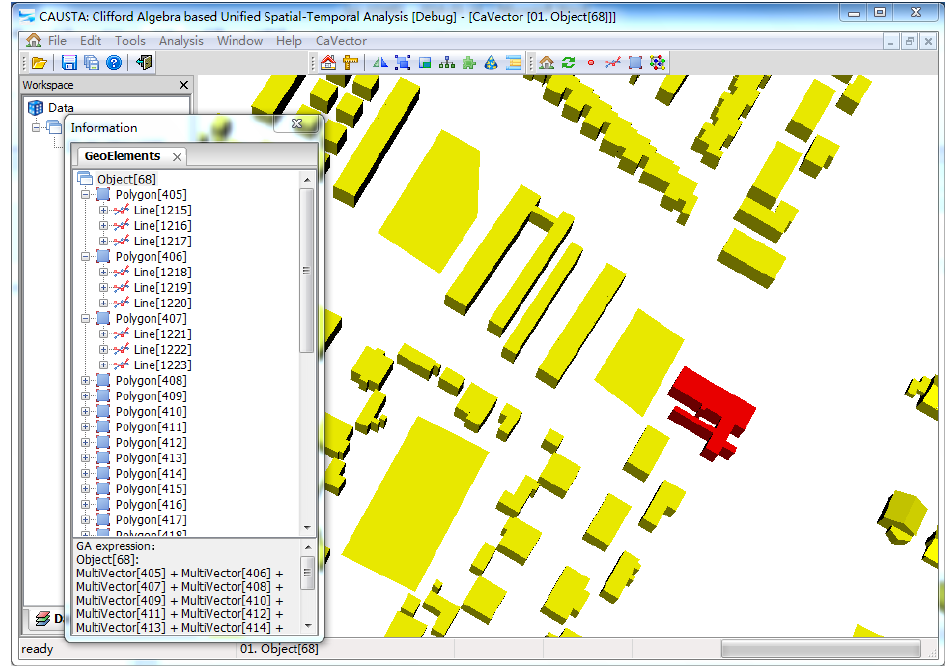
Figure 9. Multidimensional unified expression for a cadastral object within the multivector structure.